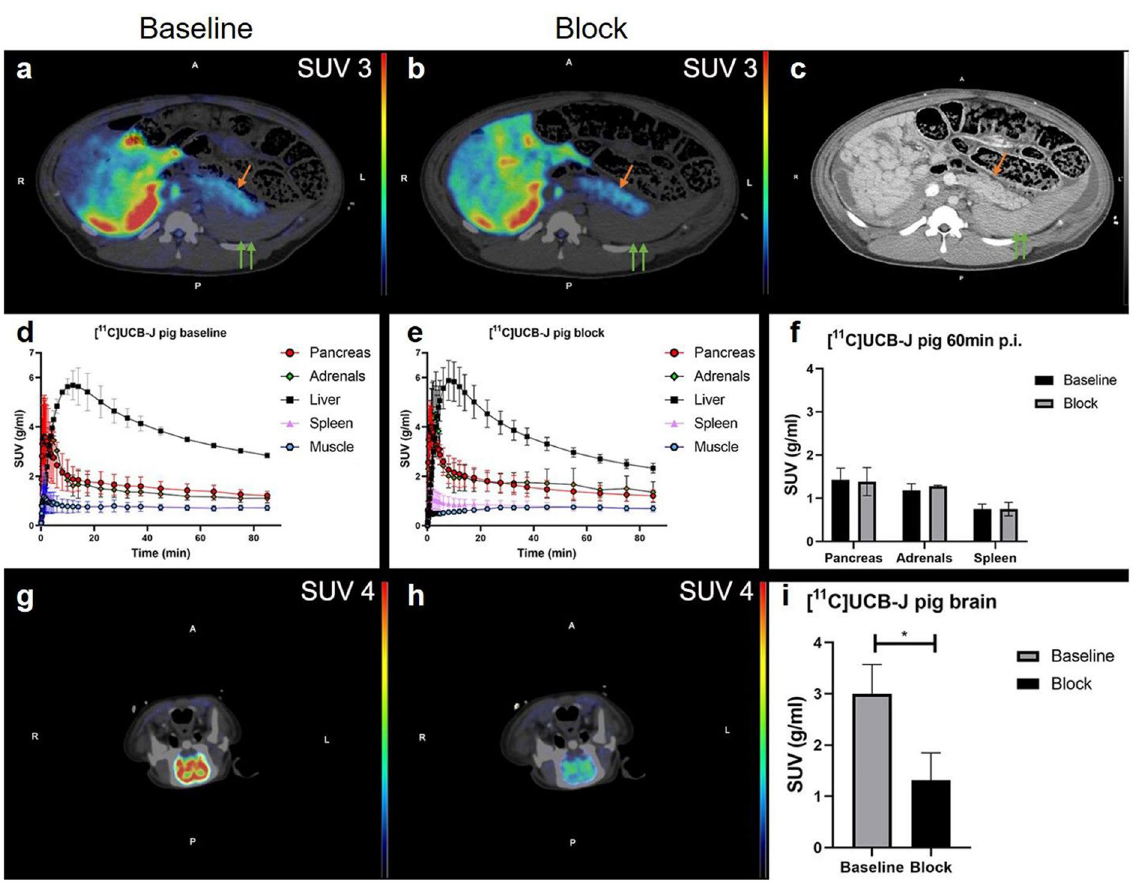
Figure 5. In vivo PET-CT imaging in pigs. Baseline ( a ) and post LEV treatment ( b ) SUV-corrected 55–90 min averaged representative images of the abdomen in pigs. The pancreas, spleen (green double arrows) and adrenal glands were reliably identified and segmented by support from contrast-enhanced CT images ( c ). Corresponding TACs of mean SUV values at baseline ( d ) and after block ( e ) did not show any decrease in pancreas ( f ) binding of [ 11 C]-UCBJ at 60 min p.i. However, the positive control tissue brain demonstrated strong binding at baseline ( g ), which was decreased in the same animal after administration of 20 mg/kg LEV ( h ) (representative, comparable images shown). Blocking of the brain binding of [ 11 C]UCB-J was observed in all three examined pigs ( i